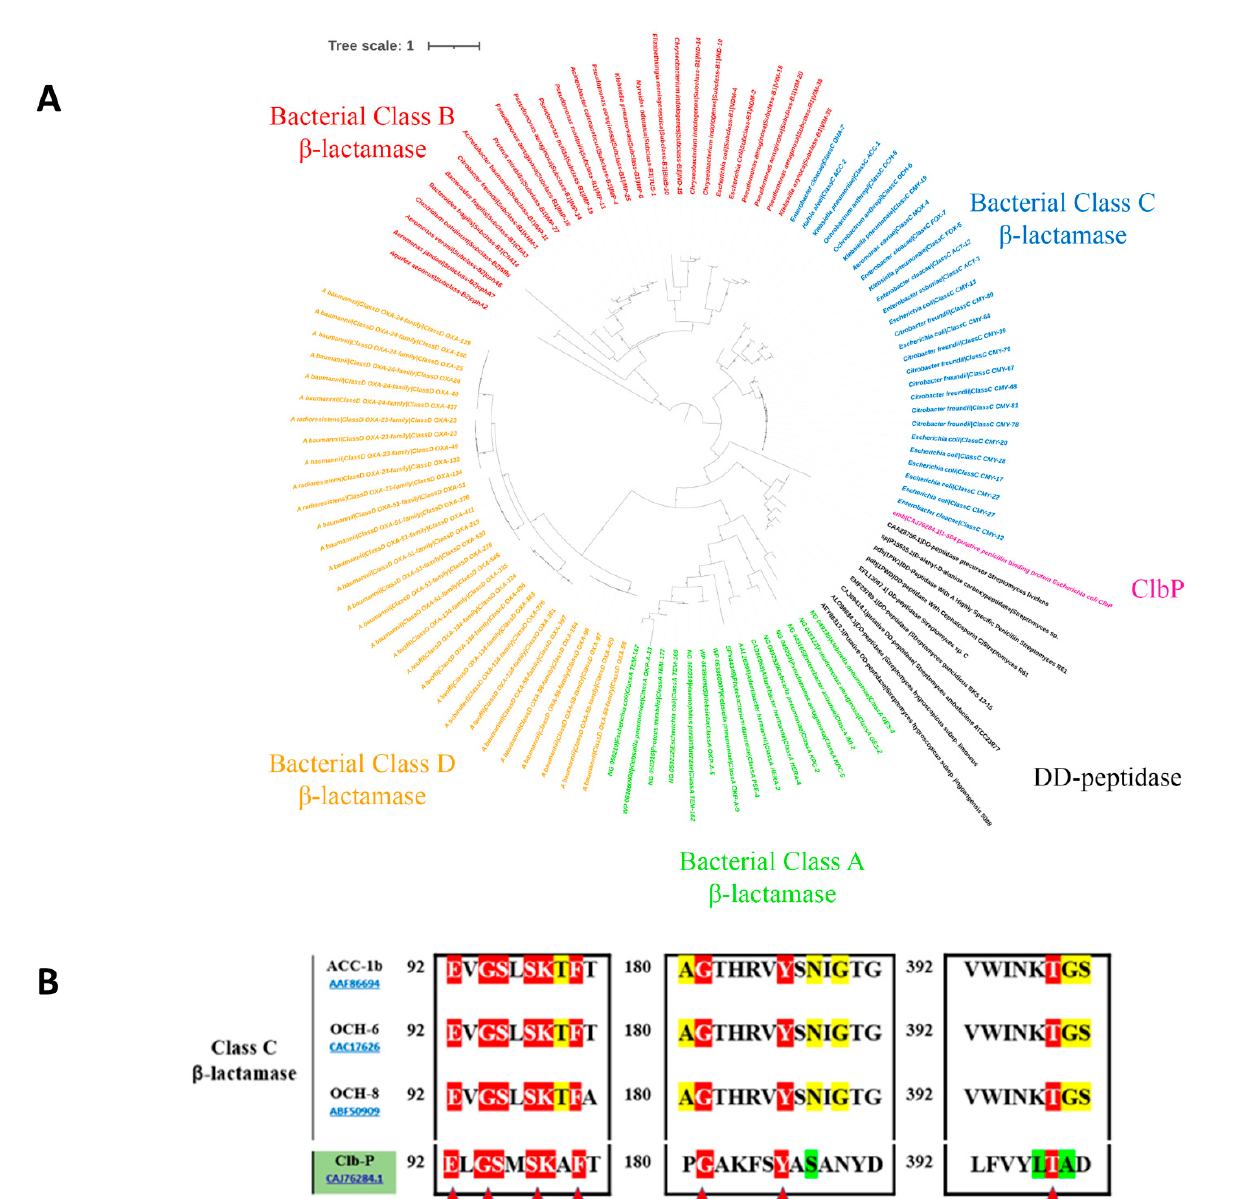
Figure 2. ( A ) Phylogenetic tree of pre-colibactin peptidase ClbP with described bacterial β -lactamase sequences. ( B ) Multiple sequence alignment was performed among class C β -lactamases and the ClbP sequence. Three characteristic motifs (motif I, II, and III) with significant catalytic residues are shown. Highly conserved catalytic residues are shown in red triangles.